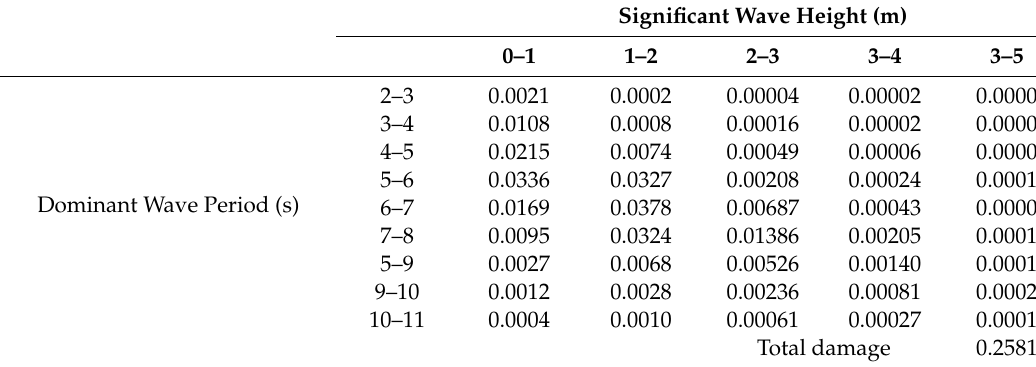
Table 8. Sea states and